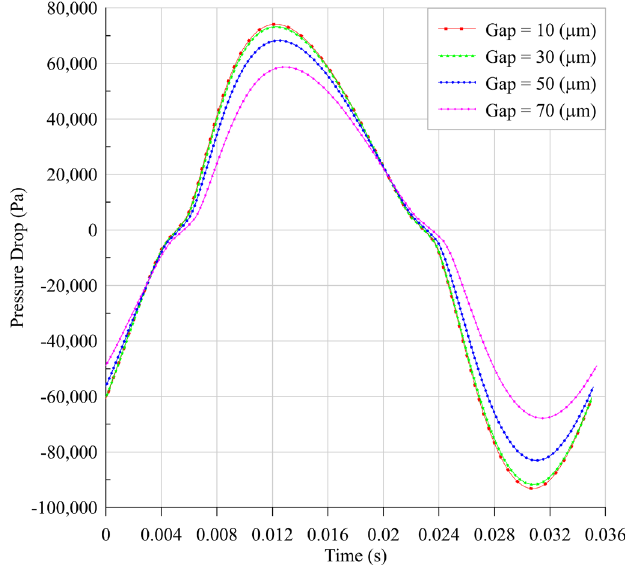
Figure 17. Effect of the gap size on the pressure drop.